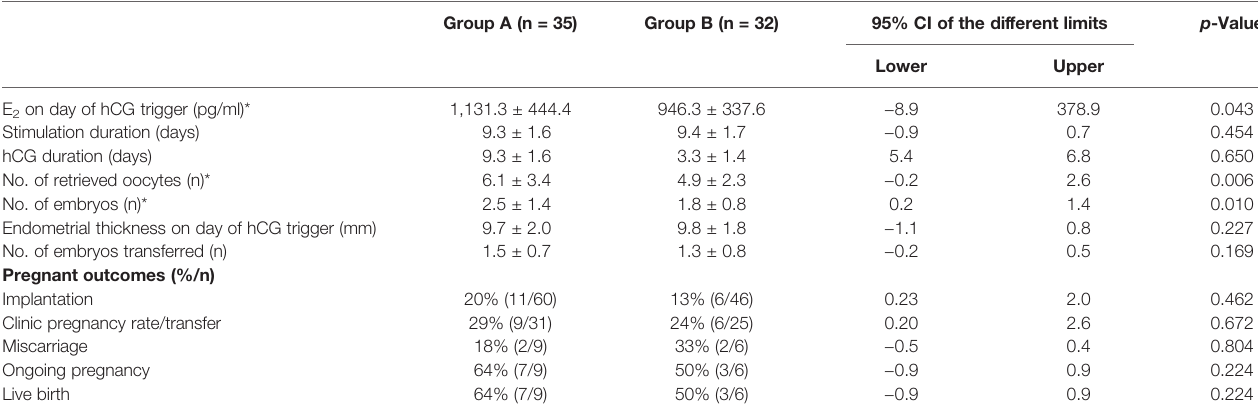
TABLE 4 | Comparison of IVF/ICSI outcomes between group A and group B.